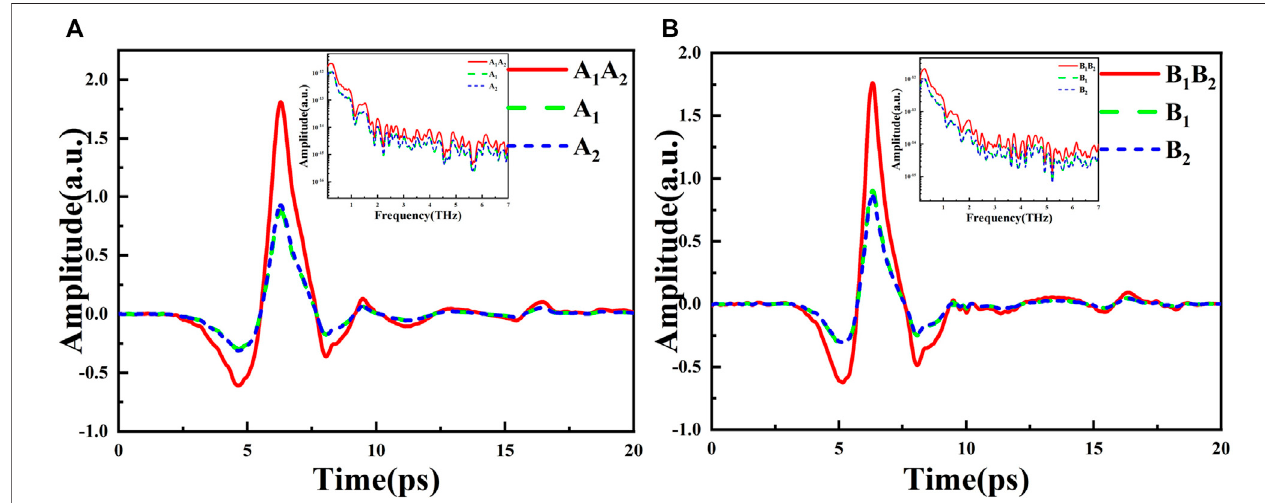
FIGURE 2 | Photoconductive detection antenna array detector at θ = 45 ° (A) The amplitude synthesis effect of A 1 , A 2 and (B) The amplitude synthesis effect of B 1 and B 2 .